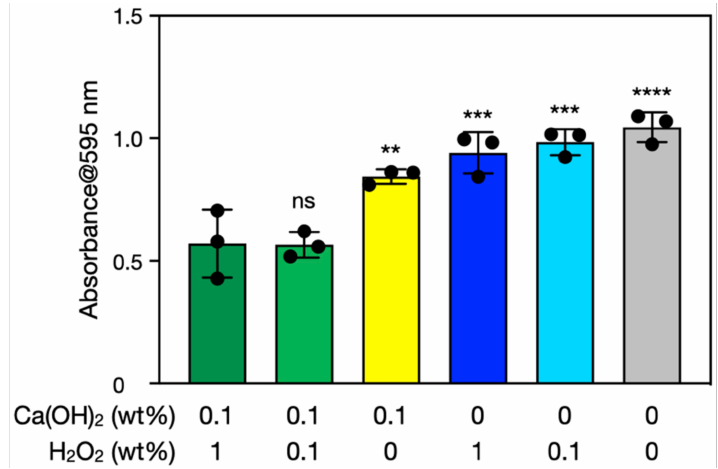
Figure 2. Semi-quantification of biofilms before and after the treatments with Ca(OH) 2 and/or H 2 O 2 for 10 min. The y -axis is the 595-nm absorbance of crystal violet extracted from the stained biofilms. The error bars represent the standard deviation of three individual trials. Statistical analysis was performed by parametric one-way ANOVA with Dunnett’s multiple comparison; ns, **, ***, and **** denote not significant, p < 0.01, p < 0.001, and p < 0.0001, respectively.